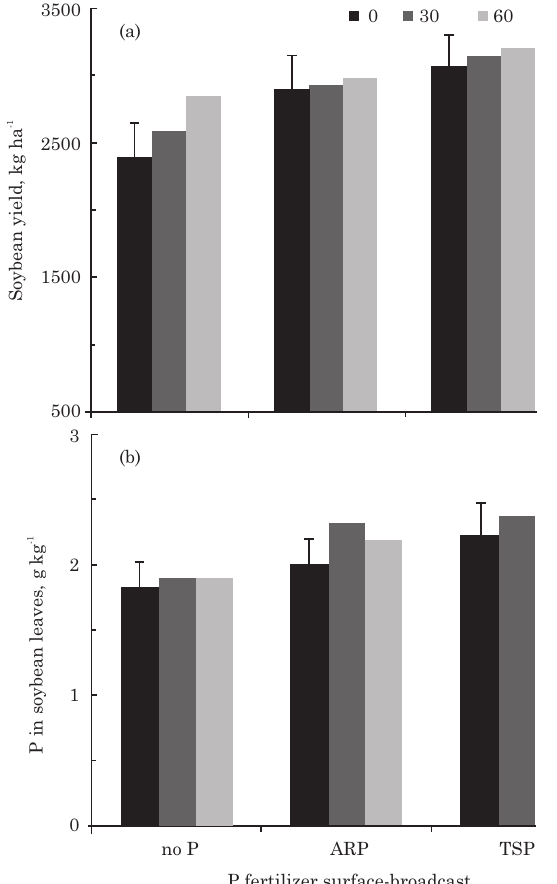
Figure 6. Soybean yields (a) and leaf P concentrations (b) as affected by surface-broadcast and furrow- applied P fertilizers. no P – no P broadcast; ARP – 80 kg ha -1 of P 2 O 5 as natural reactive Arad phosphate; TSP - 80 kg ha -1 of P 2 O 5 as triple superphosphate. Inserts 0, 30, and 60 represent kg ha -1 of P 2 O 5 applied to soybean furrows as TSP. Bars over the columns shows LSD